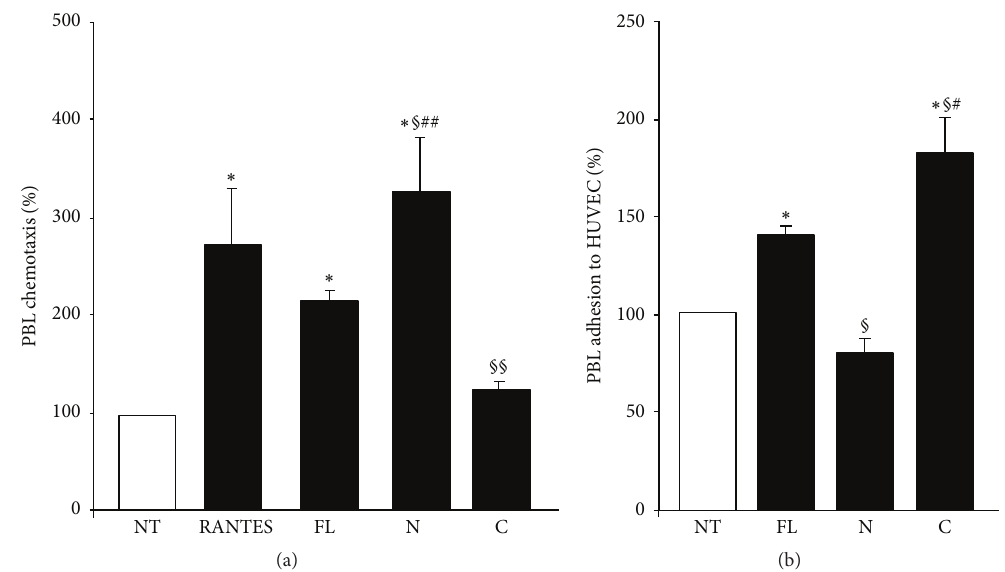
Figure 4: Effect of OPN variants on PBL migration and adhesion. (a) PBL were plated onto the apical side of matrigel-coated filters in 50 𝜇 L of medium in the presence or absence of either 10 𝜇 g/mL OPN-FL, 5 𝜇 g/mL OPN-N, or OPN-C; RANTES (10ng/mL) was loaded in the basolateral chamber as a positive control for migration. The cells that migrated to the bottom of the filters were stained using crystal violet and counted (5 fields for each triplicate filter) using an inverted microscope. (b) PBL were pretreated or not with OPN-FL, OPN-N, or OPN- C (10 𝜇 g/mL) for 30 min, washed, and then incubated together for 1h in the adhesion assay. Data are expressed as the mean ± SEM of the percentage of migration or adhesion versus the control obtained from untreated cells set at 100% from 5 independent experiments. ( ∗ 𝑝 < 0.05 ; versus the control; § 𝑝 < 0.05 ; §§ 𝑝 ≤ 0.01 versus OPN-FL; # 𝑝 < 0.05 ; ## 𝑝 ≤ 0.01 versus OPN-C or OPN-N; Wilcoxon’s signed rank